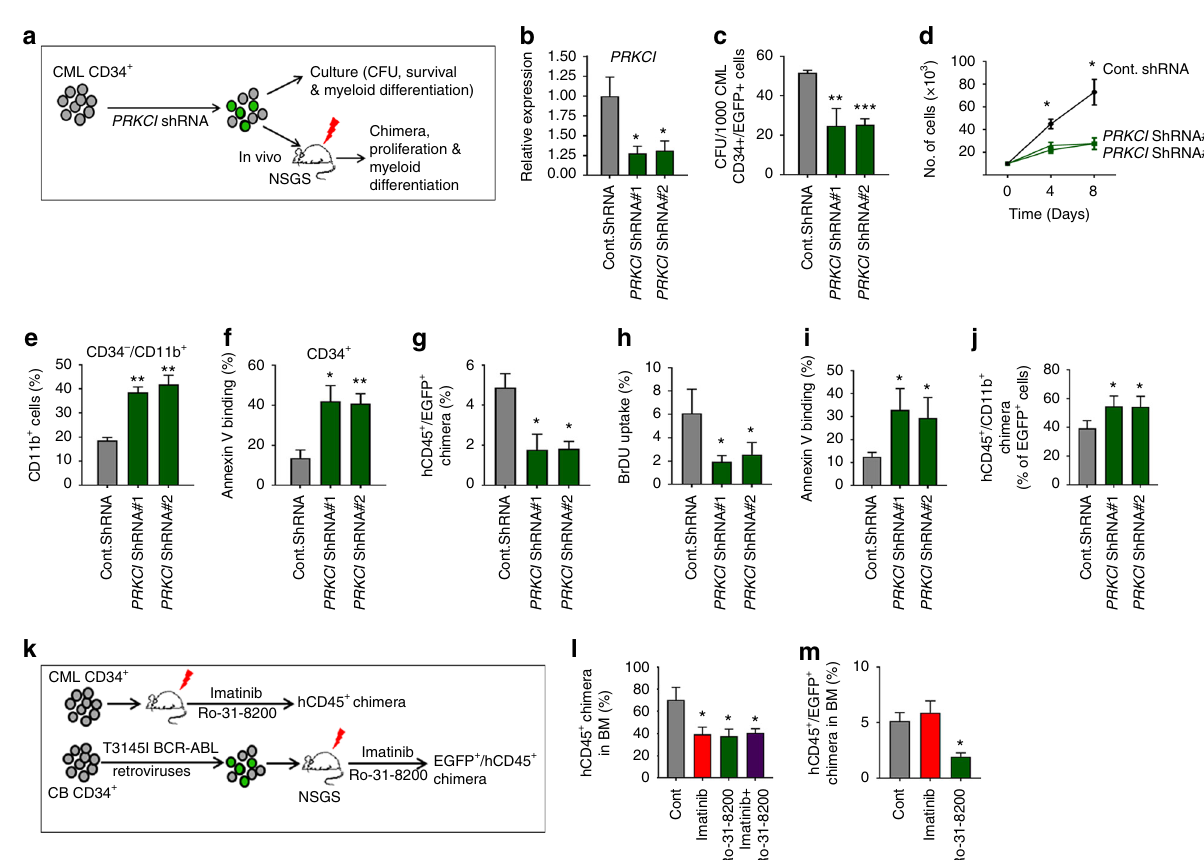
Fig. 6 aPKC ι is required for the survival and maintenance of human CML CD34 + cells. a Schematic diagram of shRNA mediated knockdown of aPKC ι in CML patient-derived CD34 + cells followed by in vitro culture as well as in vivo transplantation into NSG-S mice. b Q-RT-PCR showing shRNA mediated knockdown of aPKC ι in CML CD34 + cells. c Colony forming unit (CFU) cell assay showing reduced clonogenic ef fi ciency of aPKC ι de fi cient CML CD34 + cells. d Liquid culture expansion of control and aPKC ι de fi cient CML CD34 + cells. e FACS quanti fi cation of CD34 − /CD11b + cells derived from control and aPKC ι knocked down CML CD34 + cells grown in liquid culture medium. f FACS quanti fi cation of annexin V-binding of control/aPKC ι knocked down CML CD34 + cells growing in liquid culture expansion medium. g hCD45 + /EGFP + chimera in NSG-S mice transplanted with CML CD34 + cells transduced with control/aPKC ι shRNA lentiviruses. h , i Quanti fi cation of BrDU uptake ( h ) and annexin V-binding ( i ) of hCD45 + /EGFP + chimera in the bone marrow (BM) of NSG-S mice transplanted with control/aPKC ι shRNA transduced CML CD34 + cells. j hCD45 + /hCD11b + on EGFP + chimera in NSG-S mice transplanted with CML CD34 + cells transduced with control/aPKC ι shRNA lentiviruses. k Schematic diagram of pharmacological administration of imatinib and a pan-PKC inhibitor (Ro-31-8200) to NSG-S mice transplanted with CML CD34 + cells and T315I p210 BCR-ABL transduced CB CD34 + cells. l FACS quanti fi cation of human CD45 + cell engraftment in the BM of NSG-S mice transplanted with CML CD34 + cells and treated with either control vehicle, imatinib, Ro-31-8200 or a combination of imatinib and Ro-31-8200. Imatinib and Ro-31-8200 administration led to a similar decrease of human CML burden in the BM of NSG-S mice. m FACS quanti fi cation of hCD45 + /EGFP + chimera in the BM of NSG-S mice transplanted with T315I transduced CB CD34 + cells and treated with control vehicle, imatinib or R0-31-8200. Mice treated with the PKC inhibitor show reduced levels of human CD45 + /EGFP + chimera in the BM, whereas imatinib treatment has no effect. Cont: Control. Data are presented as mean ± SD of a minimum of two independent experiments.* p < 0.05; ** p < 0.01; *** p < 0.001, t